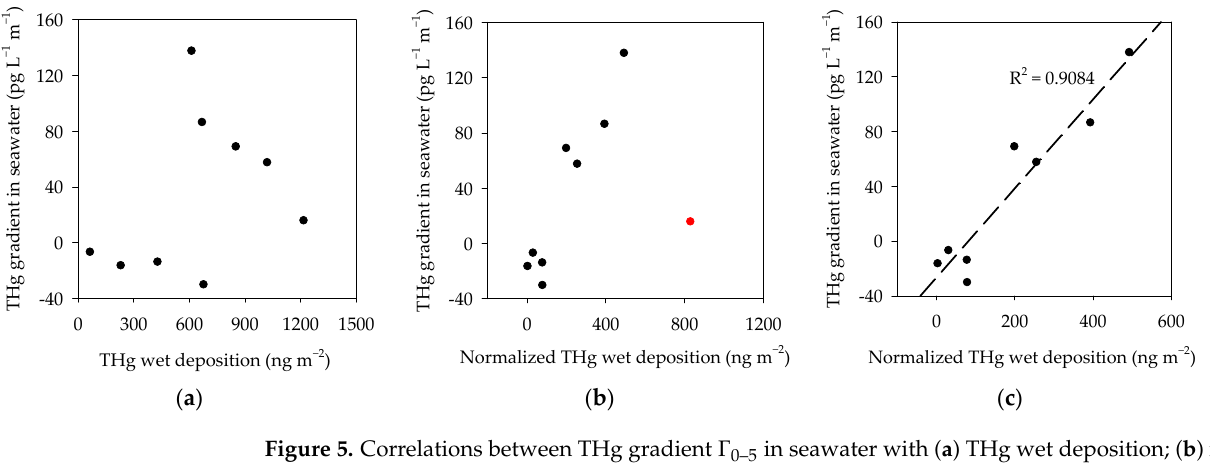
Figure 5. Correlations between THg gradient Γ 0–5 in seawater with ( a ) THg wet deposition; ( b ) nor- malized THg wet deposition; and ( c ) normalized THg wet deposition after removal of an outlier (red point).